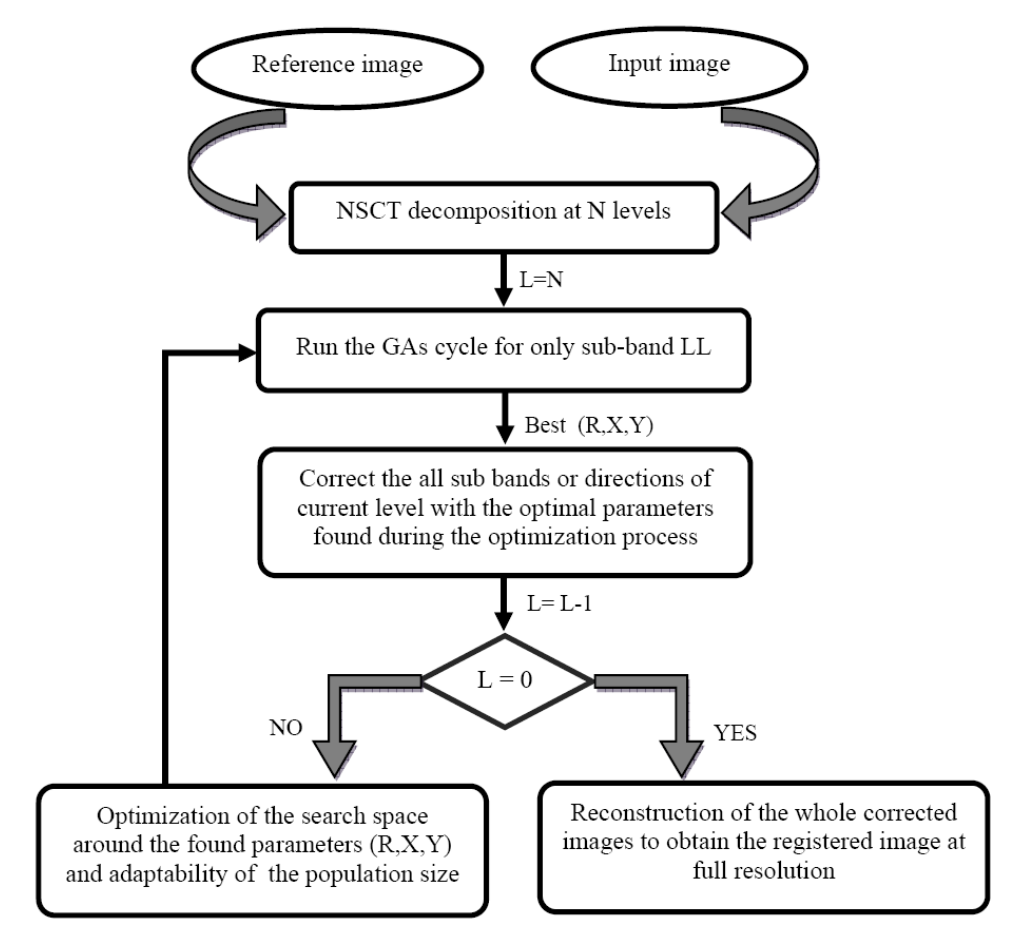
Figure 4. Image registration algorithm based on the second proposed NSCT